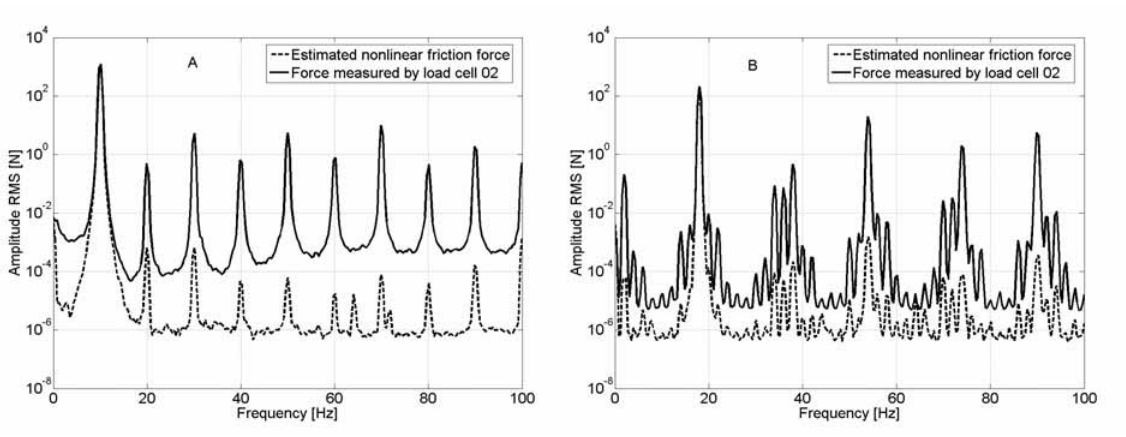
Fig. 11. Global and estimated force spectral densities: (a) at 10 Hz excitation and (b) at 18